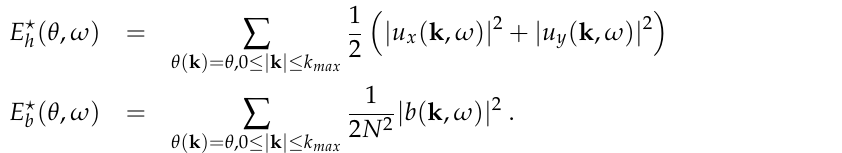
, E (cid:63) and z h